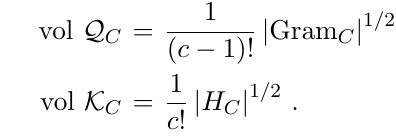
whose base is the simplex K C